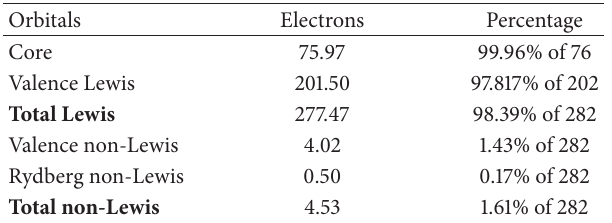
Table 3: Electron population in Lewis and non-Lewis orbitals for